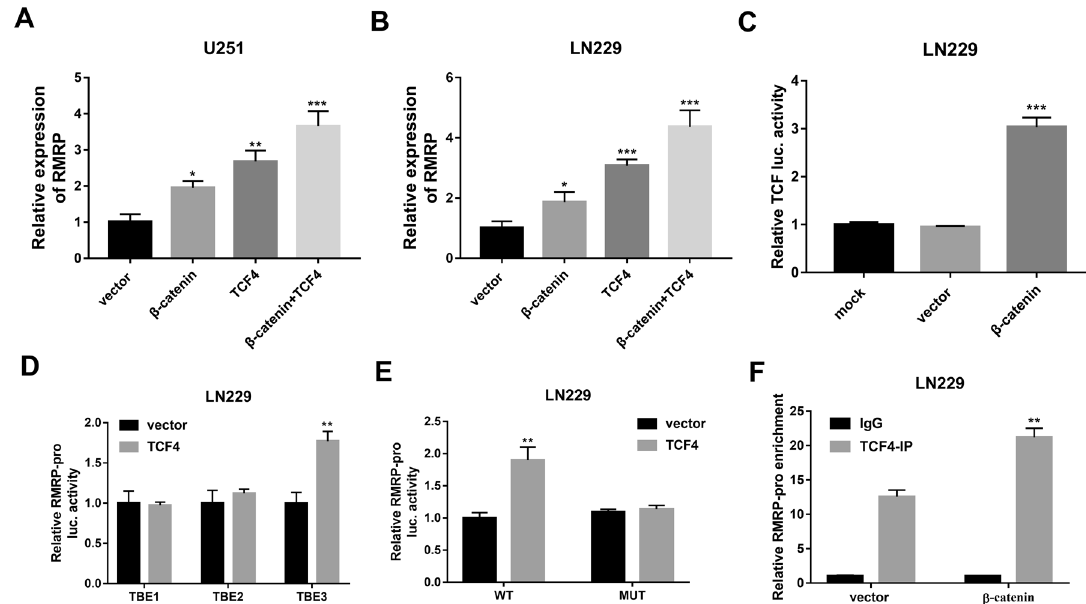
Fig. 8 β -catenin facilitated RMRP transcription by TCF4 in glioma cells. A , B U251 and LN229 cells were transfected with pcDNA3.1 empty vector, pcDNA- β -catenin, pcDNA-TCF4, or pcDNA- β -catenin + pcDNA-TCF4. Forty-eight hours later, the RMRP level was examined by RT-qPCR assay ( n = 3). C LN229 cells were transfected with TCF/LEF1-Luc reporter, TCF/LEF1-Luc reporter + pcDNA3.1 empty vector, or TCF/LEF1-Luc reporter + pcDNA- β -catenin, followed by the detection of luciferase activity at 48 h after transfection. D LN229 cells were co-transfected with pRL-TK Renilla luciferase plasmid, pGL3-luc-TBE1/pGL3-luc-TBE2/pGL3-luc-TBE3 and pcDNA3.1-TCF4 plasmid/pcDNA3.1 empty vector. At 48 h post-transfection, luciferase activities were measured. E LN229 cells were co-transfected with pRL-TK Renilla luciferase plasmid, pcDNA3.1- TCF4 plasmid/pcDNA3.1 empty vector, and pGL3-luc-TBE3(WT)/pGL3-luc-TBE(MUT) reporter. Forty-eight hours later, luciferase activities were measured. F LN229 cells were transfected with pcDNA3.1 empty vector or pcDNA- β -catenin. Forty-eight hours later, a CHIP assay was carried out using TCF4 or IgG antibody. The level of RMRP gene fragment enriched by IgG or TCF4 antibody was measured by PCR. ** P < 0.01. *** P <